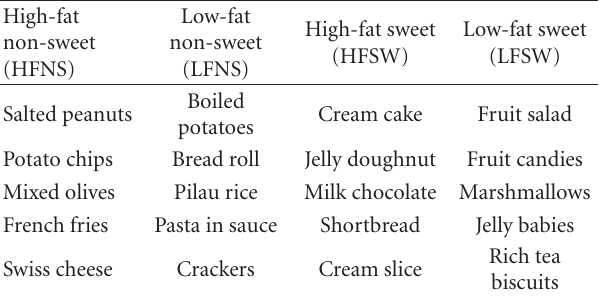
Table 1: Photographic food images and food categories used in the procedure.